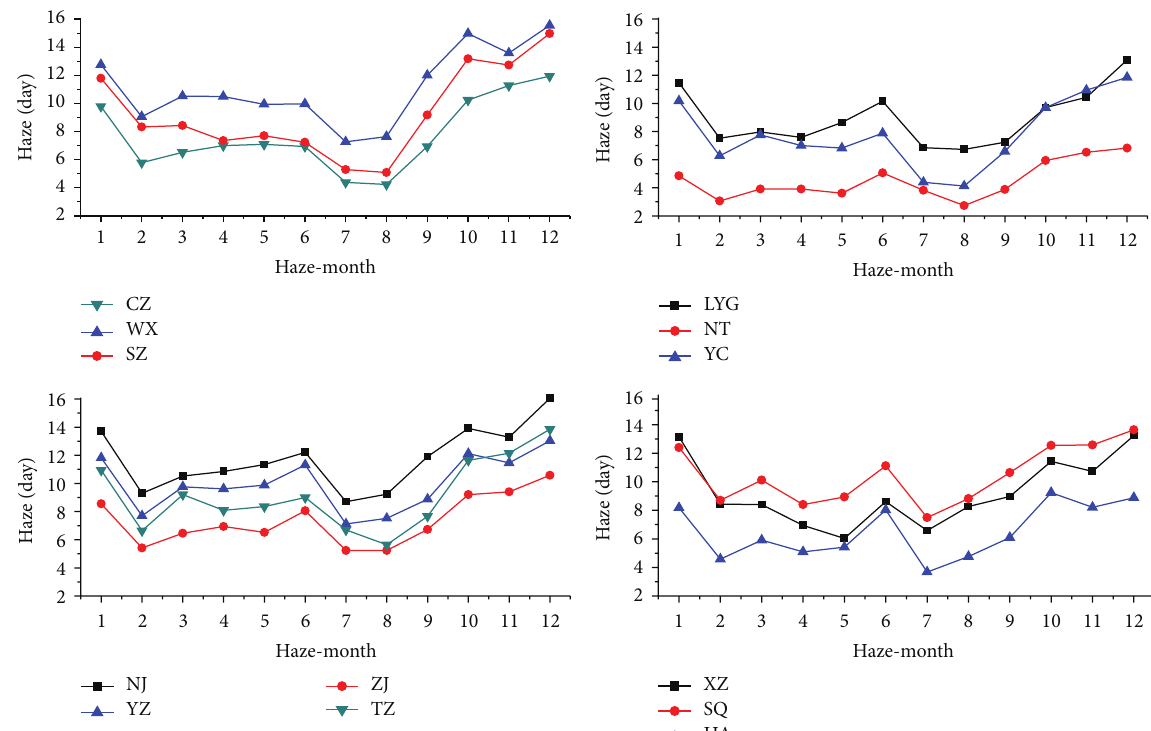
Figure 4: Monthly changes of hazy day during 1980 and 2012 (yearly